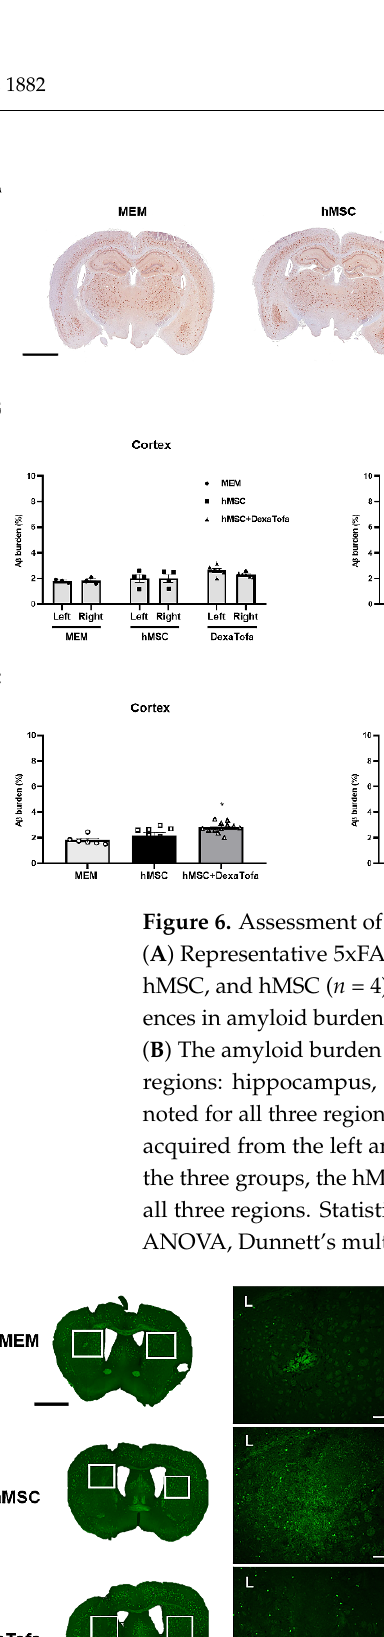
10 of 18 Figure 5. Comparison of amyloid burden between the injected (left caudate putamen) and non-in- jected (right caudate putamen) areas of 5xFAD mice. Representative images of 6E10 stained sections